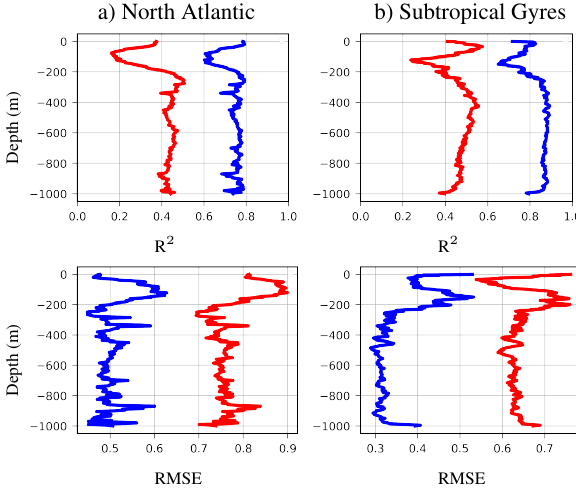
Figure 4. Depth-associated statistics ( R 2 top and RMSE bottom) of the comparison of b bp values estimated from RF and RLR models (in blue and red, respectively) to BGC-Argo measurements on the test dataset for the a) North Atlantic and b) the Subtropical